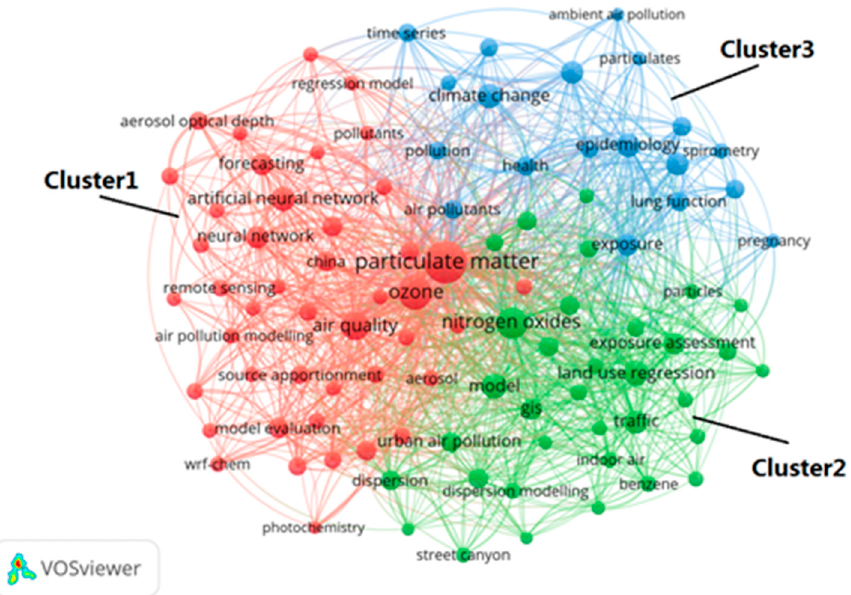
Figure 2. A co-occurrence map of keywords in the selected papers involving air pollutant prediction from 1990 to 2018 (note: the node size in the figure represents the frequency of keywords, and the connection between nodes represents the co-occurrence of keywords; the more connections, the closer the relationship).